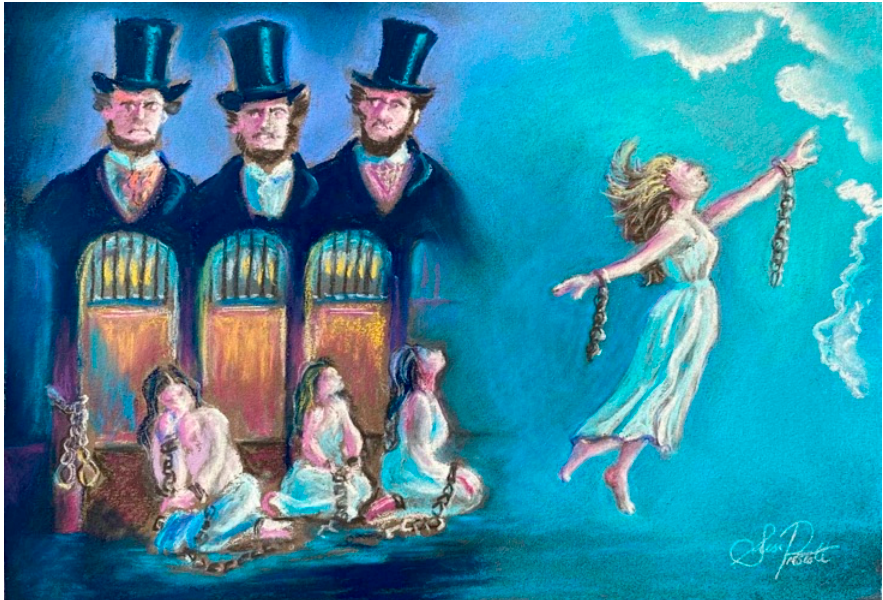
Figure 7. 19th Century humanitarians condemned and maligned. Those who advocated against physically restraining the mentally ill (many of them women, who may not have even had mental illness) were ridiculed as naïve ‘utopians’. Fortunately, their dream came to pass. Art by S.L.P.